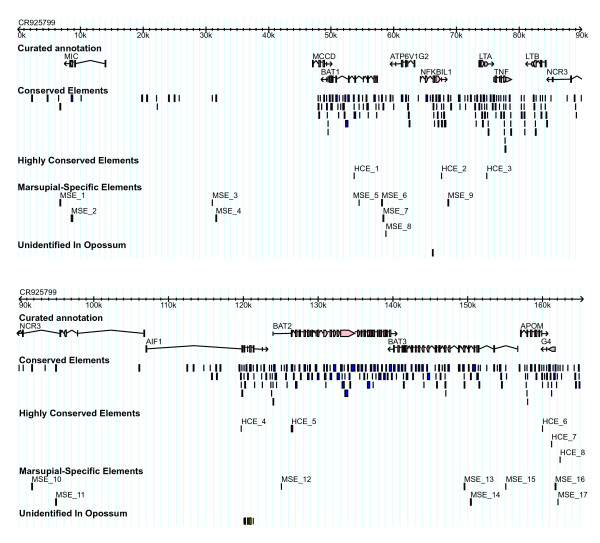
Gene map and predicted conserved elements. The gene annotation is based on curated GenomeScan predictions and known tammar wallaby sequences (TNF and LTA). Conserved Elements were predicted using phastCons [15] and three subsets – the Highly Conserved Elements, Marsupial-Specific Elements and Unidentified In Opossum – were identified from the percent identity between the reference sequence and each of the aligned species. This data can be viewed on the tammar wallaby inflammatory region browser [21].